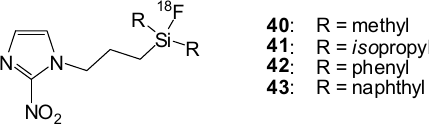
Figure 15. Structures of 18 F- silicon-based nitromidazoles 40–43 intended for hypoxia-imaging.